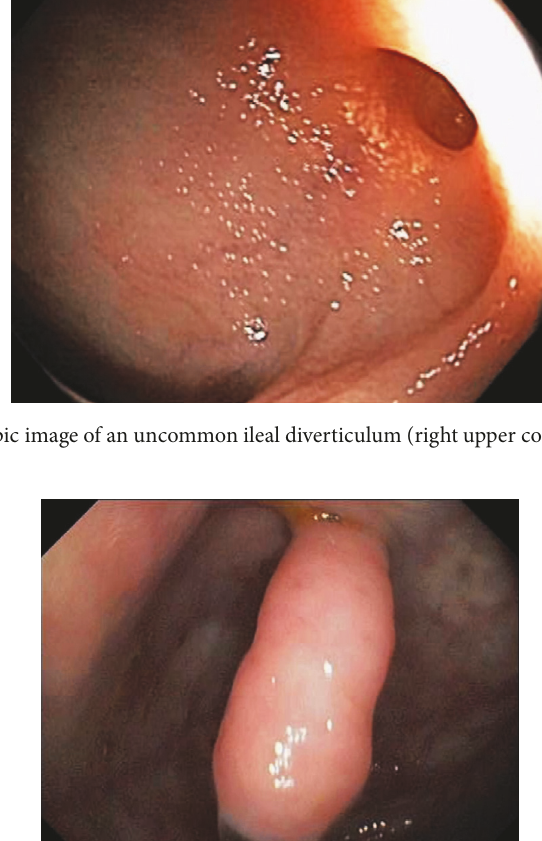
activated charcoals, and bismuth can turn stool black.